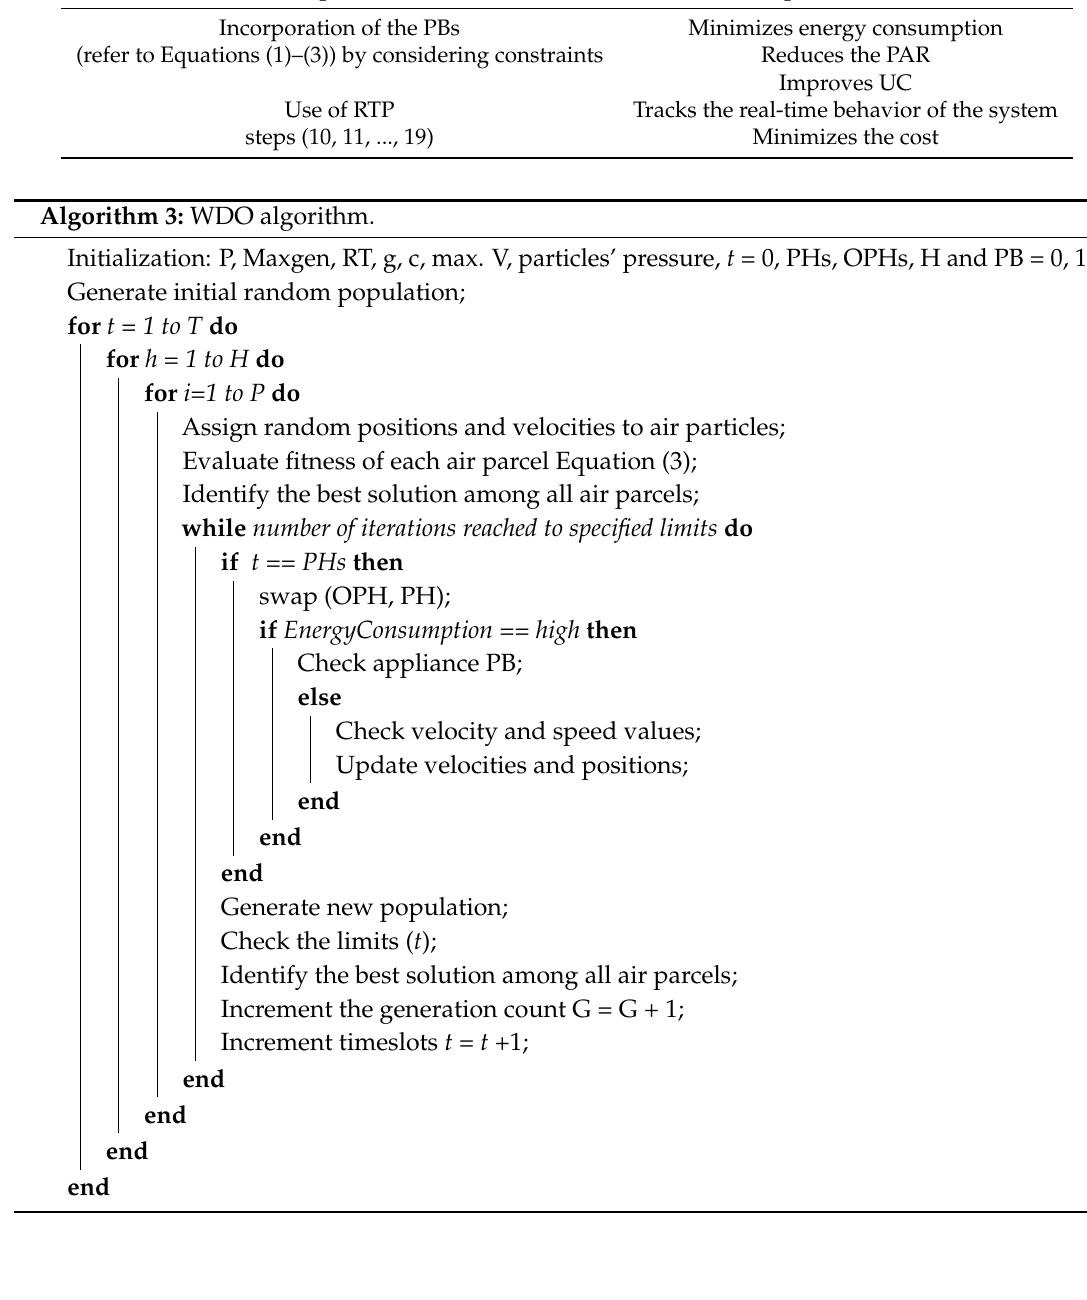
Table 6. Adaptations in WDO.